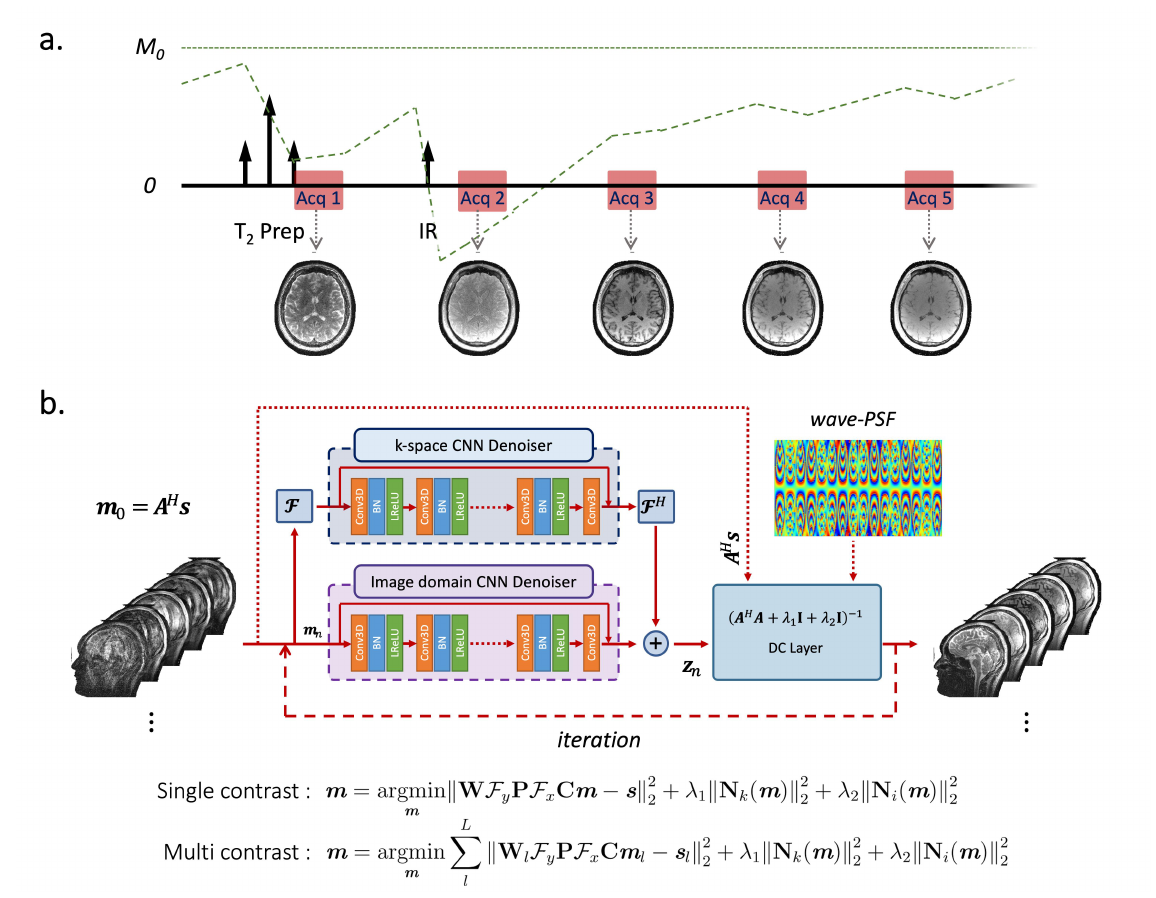
Figure 1. ( a ) 3D-QALAS sequence diagram. Five turbo-flash readout trains are played repeatedly until all k -space is acquired. The first readout succeeds a T 2 -preparation module, and the remaining four readouts follow an inversion pulse that captures T 1 dynamics. ( b ) Wave-MoDL diagram for multicontrast joint reconstruction. A = W F y P F x C presents the forward model of wave-encoding. Convolutional regularizers are applied in both image- and k -space, which are combined with data consistency (DC) layers in an unrolled network structure. The model is trained in a supervised manner where the loss function measures the fidelity with respect to high-quality reconstructions at mild R = twofold